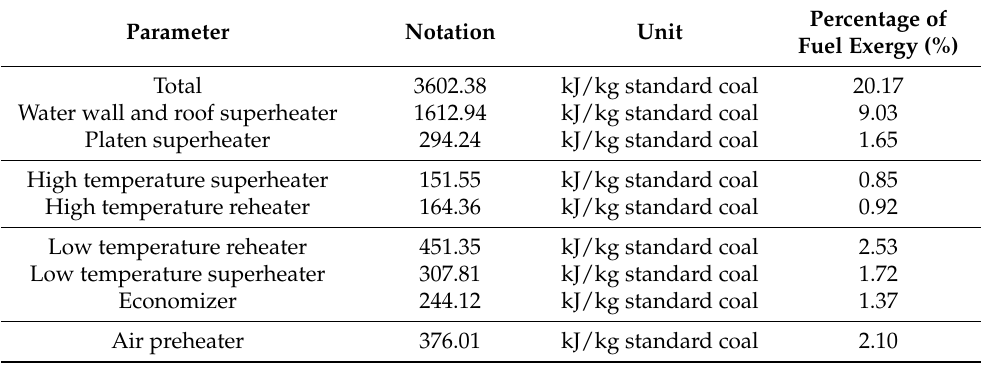
Table 10. Distribution of heat transfer exergy loss of boiler under 50% BMCR load. Table 9. Distribution of heat transfer exergy loss of boiler under 75% BMCR load.